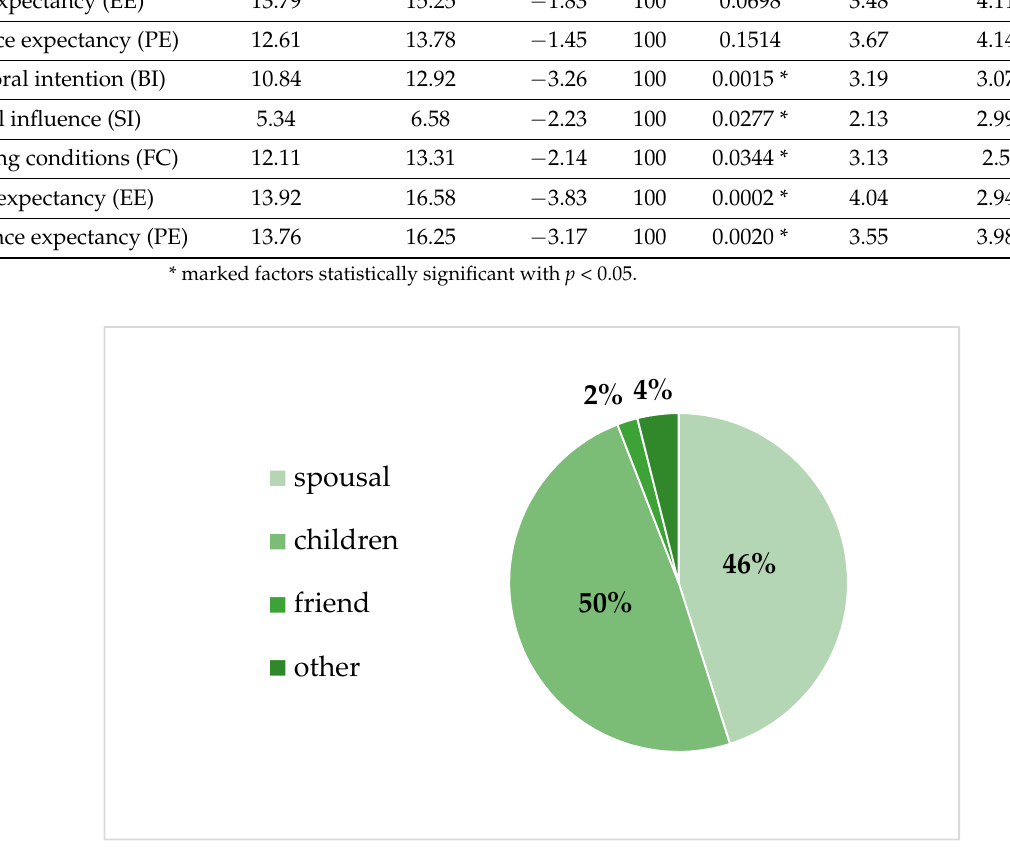
Figure 1. Study population characteristics—caregiving relationship.